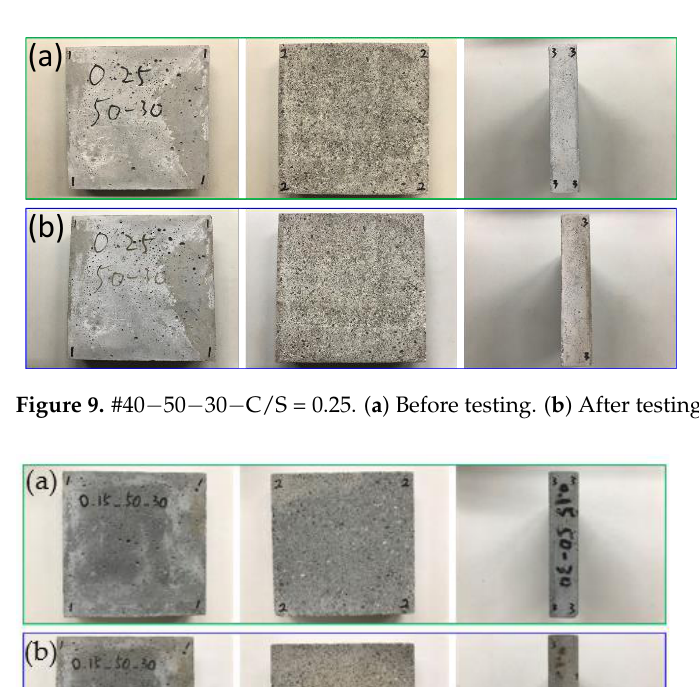
Figure 8. #40 − 50 − 30 − C/S = 0.35. ( a ) Before testing. ( b ) After testing.